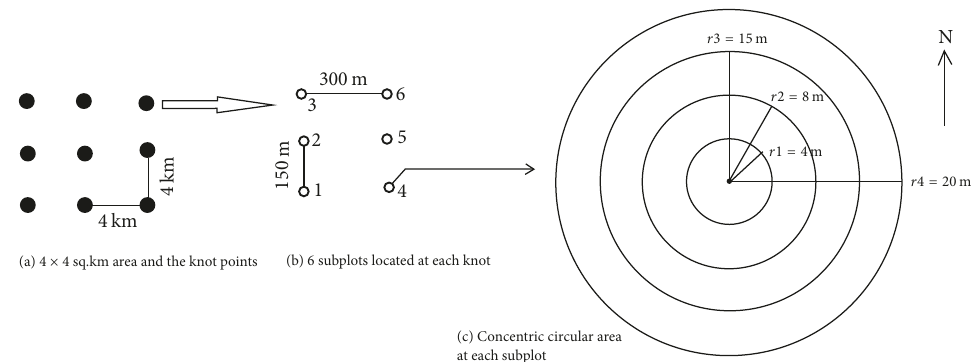
Figure 3: Plots (a), subplots (b), and four concentric circular areas with varying radii